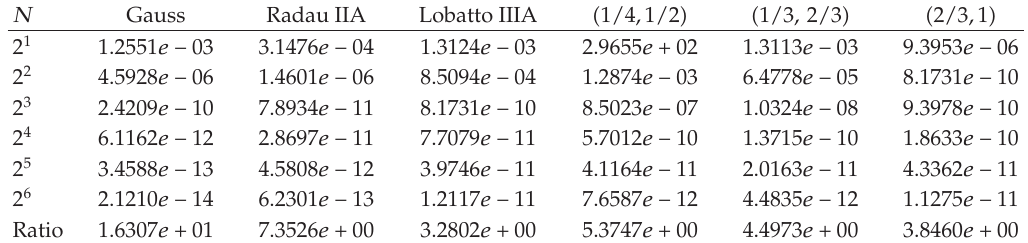
Table 1: The absolute values of absolute errors of u h for example (cid:2) 7.1 (cid:3) with m (cid:4) 2.